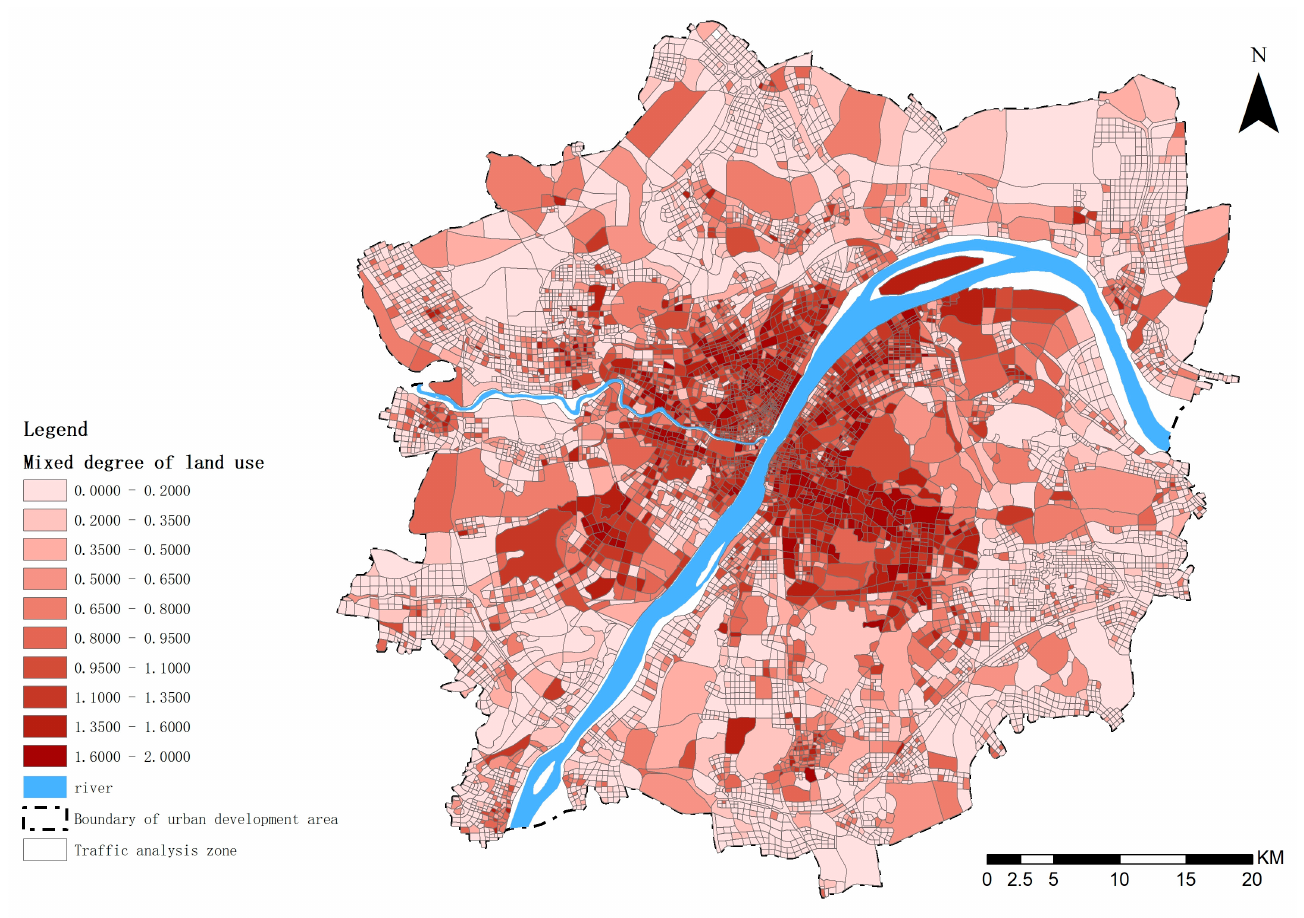
Figure 8. Mixed degree of land use.